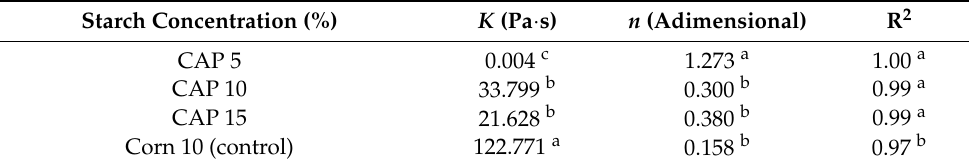
Table 8. Power-law model parameters for Ceiba aesculifolia subsp. parvifolia tuber starch. Starch Concentration (%) K (Pa · s) n (Adimensional) R 2 CAP 5 0.004 c 1.273 a 1.00 a CAP 10 33.799 b 0.300 b 0.99 a CAP 15 21.628 b 0.380 b 0.99 a Corn 10 (control) 122.771 a 0.158 b 0.97